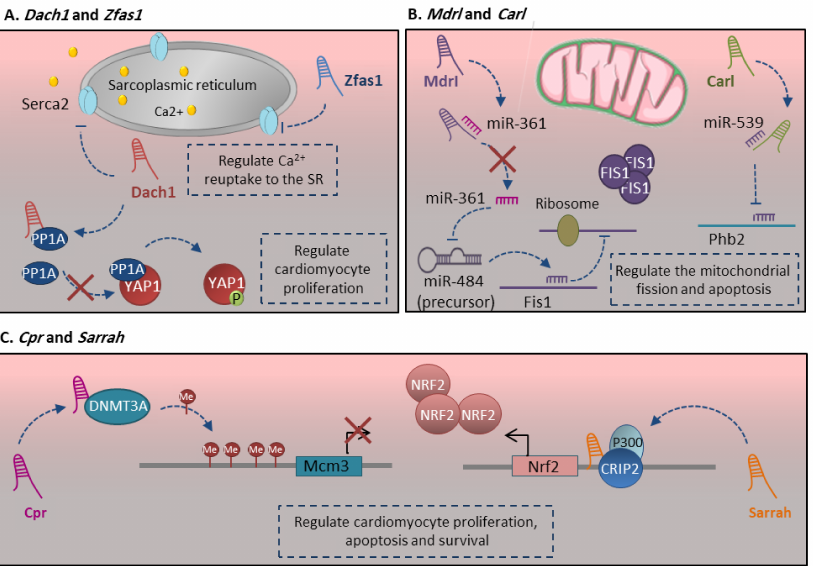
Figure 5. The regulatory function of main lncRNAs related to cardiomyocyte maturation. ( A ) Zfas1 and Dach1 manipulate the cardiac function by regulating Ca2+ homeostasis, proliferation and apoptosis in mature cardiomyocytes. This happened through negative regulation of Serca2a through either its expression repression or functional restriction and regulating the Hippo signaling pathway. ( B ) Carl and Mdrl-lncRNAs regulate mitochondrial fission and apoptosis through regulating the combination of miRNAs and transcription factors in adult cardiomyocytes. Carl lncRNA sponges miR-539 in the cardiomyocytes, which in turn upregulates the expression of Phb2 as its target gene. Mdrl-lncRNA has direct interaction with miR-361 and downregulates its expression levels, which in turn promotes the processing of pri-miR-484 and represses the Fis1 expression. ( C ) Cpr lncRNA attenuates the cardiomyocyte proliferation in postnatal and adult hearts through direct interaction and recruitment of DNMT3A protein Mcm3 promoter to repress its expression. Sarrah lncRNA regulates cardiomyocyte survival and enhances the contractile capacity of adult cardiomyocytes through activating the NRF2 signaling pathway. Sarrah directly binds to the promoter region of the Nrf2 gene through RNA-DNA triple helix formation and recruits CRIP2 and p300 transcription factors to induce its expression. More details are described within the